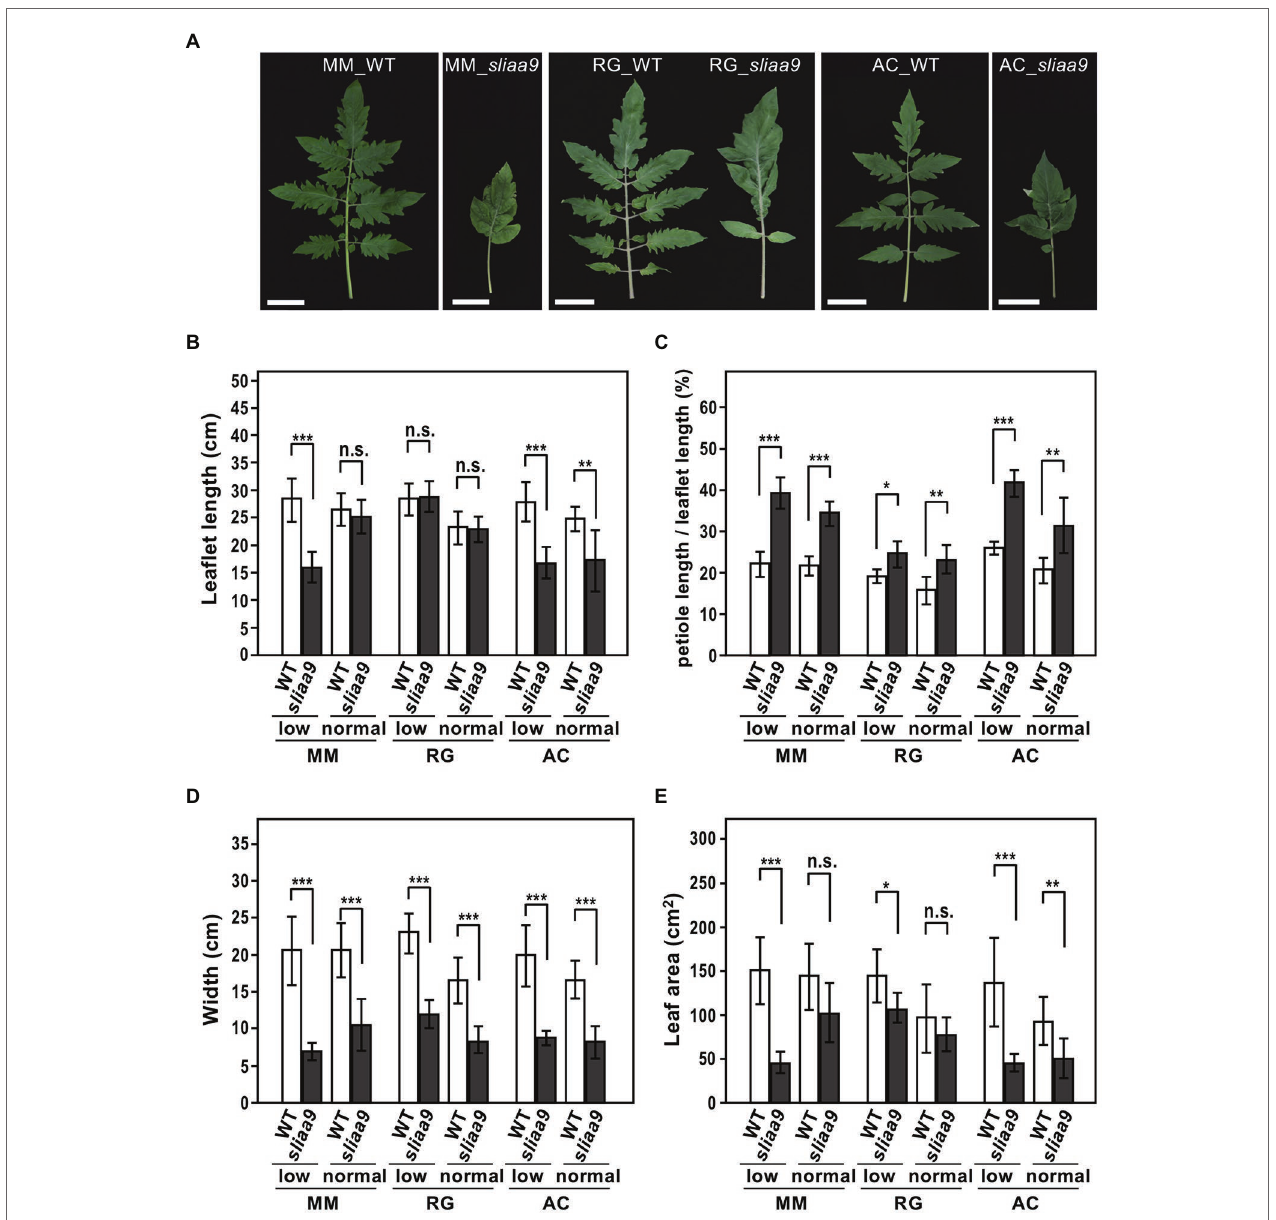
FIGURE 3 | Altered leaf morphology of sliaa9 mutants in three tomato cultivars. (A) Leaf morphology of sliaa9 mutants and wild-type plants grown under low light conditions. Bars = 5 cm. (B–E) Leaflet length (B) , the ratio of petioles to total leaf length (C) , leaf width (D) , and leaf area (E) in sliaa9 plants and the wild-type. T2 lines from MM#2-13, RG#4-1, and AC#1-1 (T1 lines) were analyzed. Data are means ± S.D. of 2–5 leaves of individual T2 plant line (total 2–4 lines; n = 6–10). * p < 0.05, ** p < 0.01, and *** p < 0.001 are determined by Student’s t tests. n.s., not